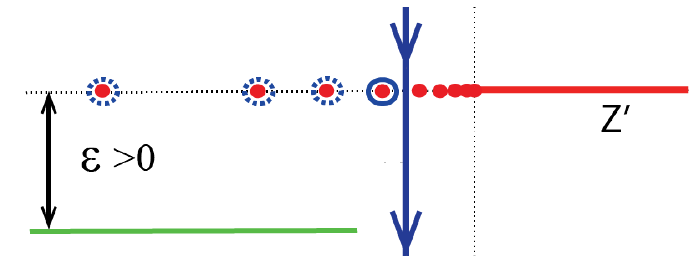
Figure 5. Analytic continuation to ε = − Γ /2. The low-lying poles of g x Riemann sheet of g y , and they are denoted by dotted 1